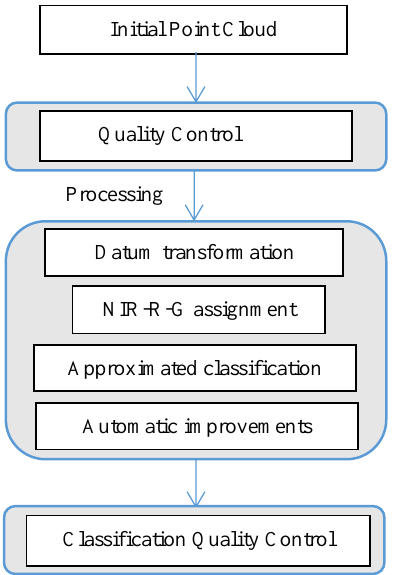
Figure 1 – PNOA-LiDAR Point Clouds processing flow chart